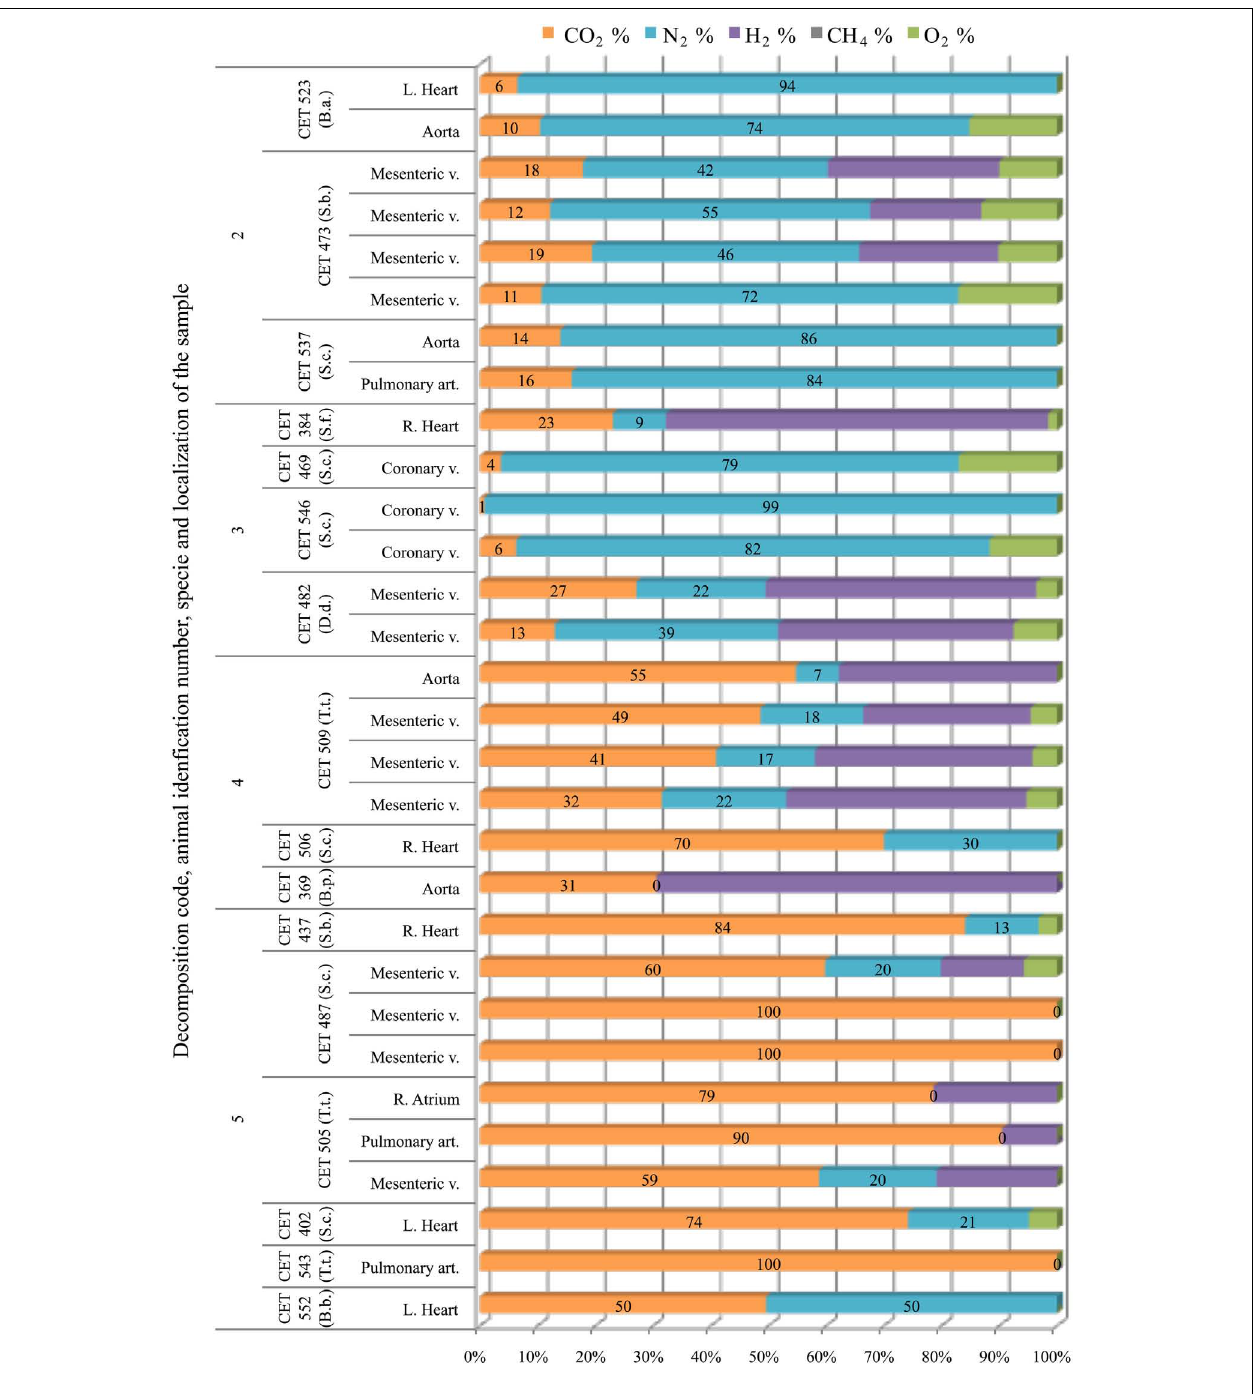
truncatus ; B.p., Balaenoptera physalus ; B.b., Balaenoptera borealis ), in different tissues and decomposition codes, illustrating the contribution of each gas to the total amount in percentage μ mol.